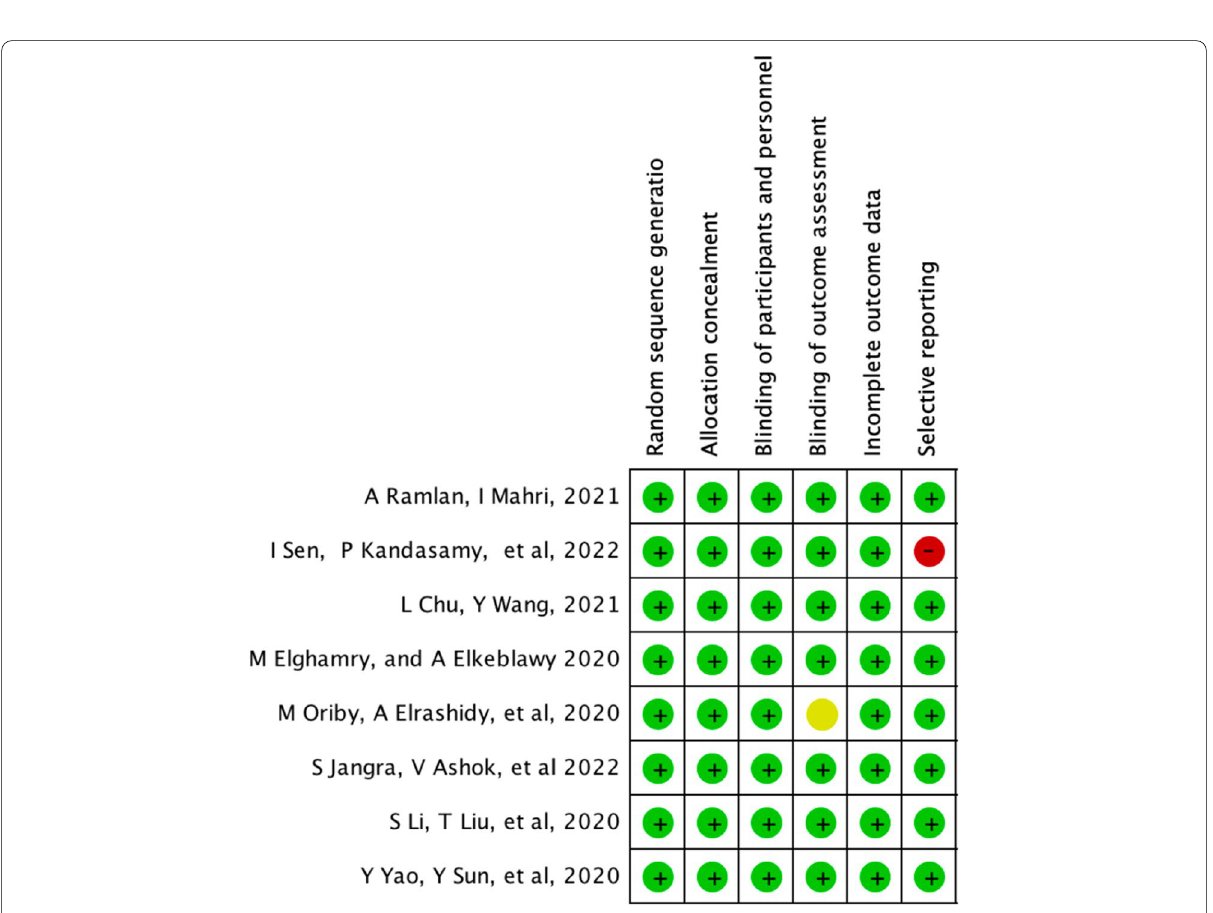
Fig. 3 Bias risk summary using RoB